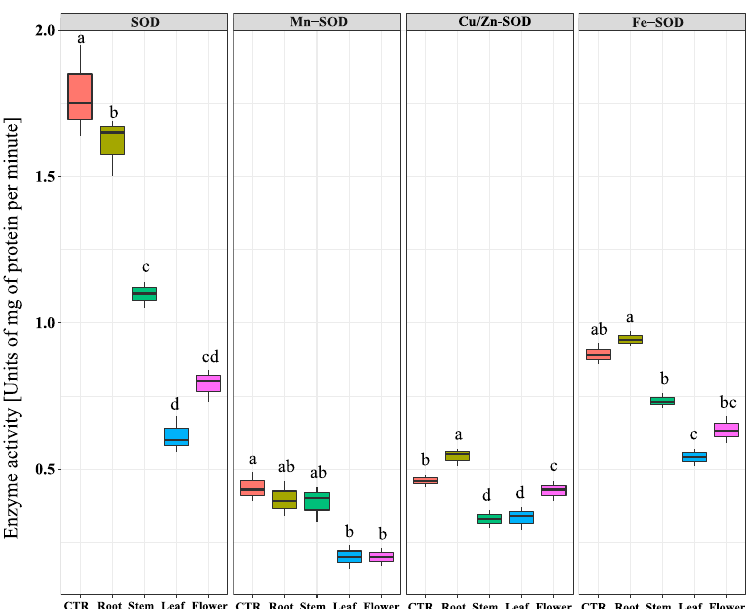
Figure 5. Effect of N. meyeri extracts on SOD production in C. campestris (dodder) plants. Dodder plants were treated either by distilled water (CTR) or extracts from different part of N. meyeri. Different letters indicate statistically significant differences calculated by Duncan multiple mean comparison method (n = 3, p -value < 0.05).